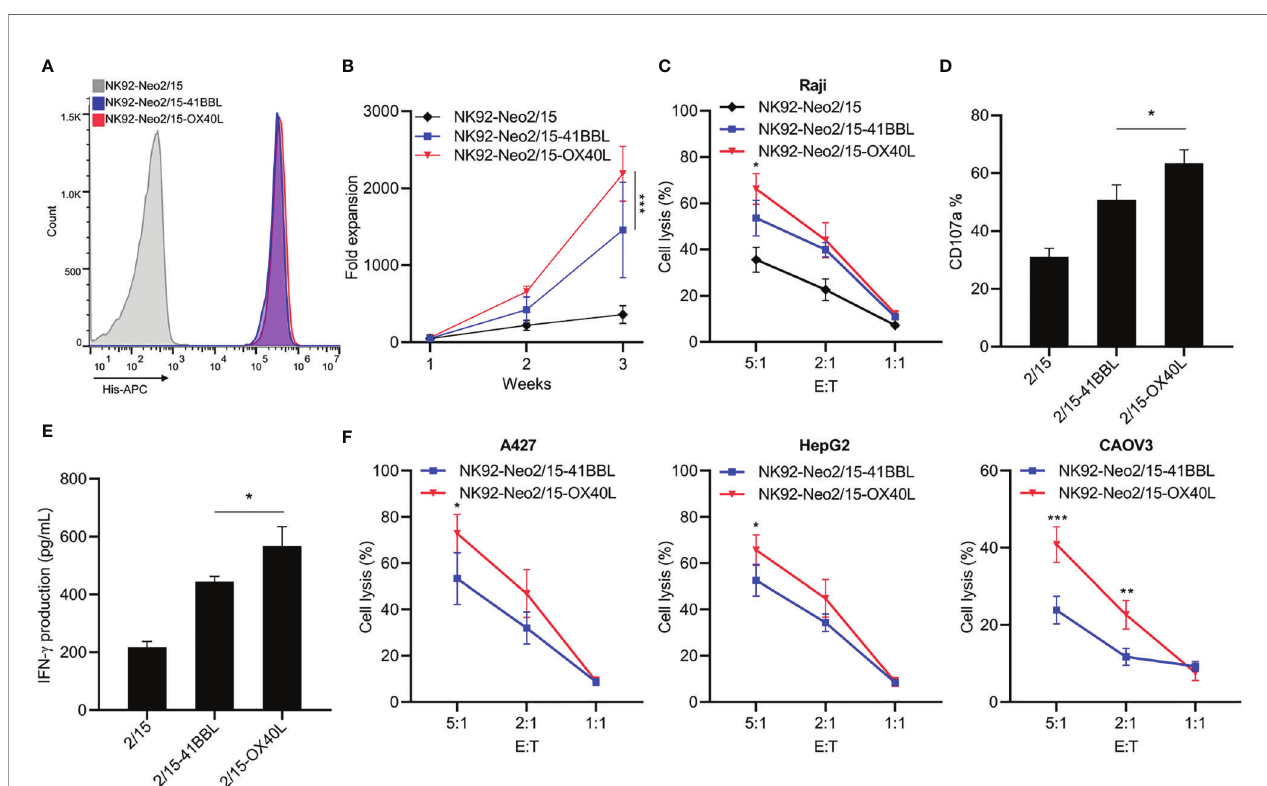
FIGURE 2 | Generation and characterization of OX40L or 4-1BBL armed feeder cells (*p<0.05, **p<0.01, ***p<0.001). (A) Genetically knock-in OX40L or 4-1BBL in NK92-Neo2/15 clone N02 and analyzed by fl ow cytometry. (B) NK cells co-cultured with irradiated NK92-Neo2/15-41BBL or NK92-Neo2/15- OX40L, cell expansion fold was measured. (C) Cytotoxicity assay to measure NK92-Neo2/15-41BBL or NK92-Neo2/15- OX40L expanded NK cells in Raji cell. (D) NK cell activation of E:T=5:1 was determined by FACS staining for CD107a expression. (E) IFN- g production in the supernatants of E:T=5:1 were evaluated by ELISA. (F) In vitro cytotoxicity assay to measure NK92-Neo2/15-41BBL or NK92-Neo2/15- OX40L expanded NK cells in A427, HepG2 and CAOV3